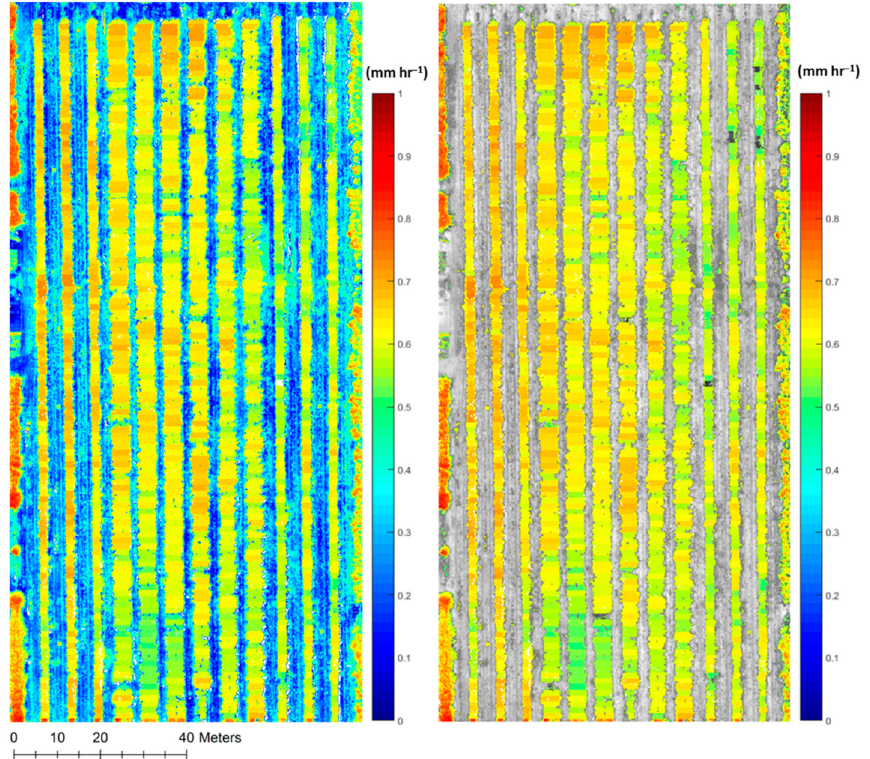
Figure 8. The estimated ET map (mm h − 1 ): ( left ) the ET distribution over the orchards; ( right ) the tree ET with excluded background